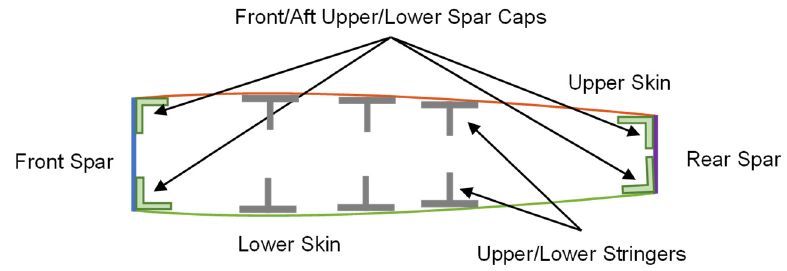
Figure 3. Cross-section